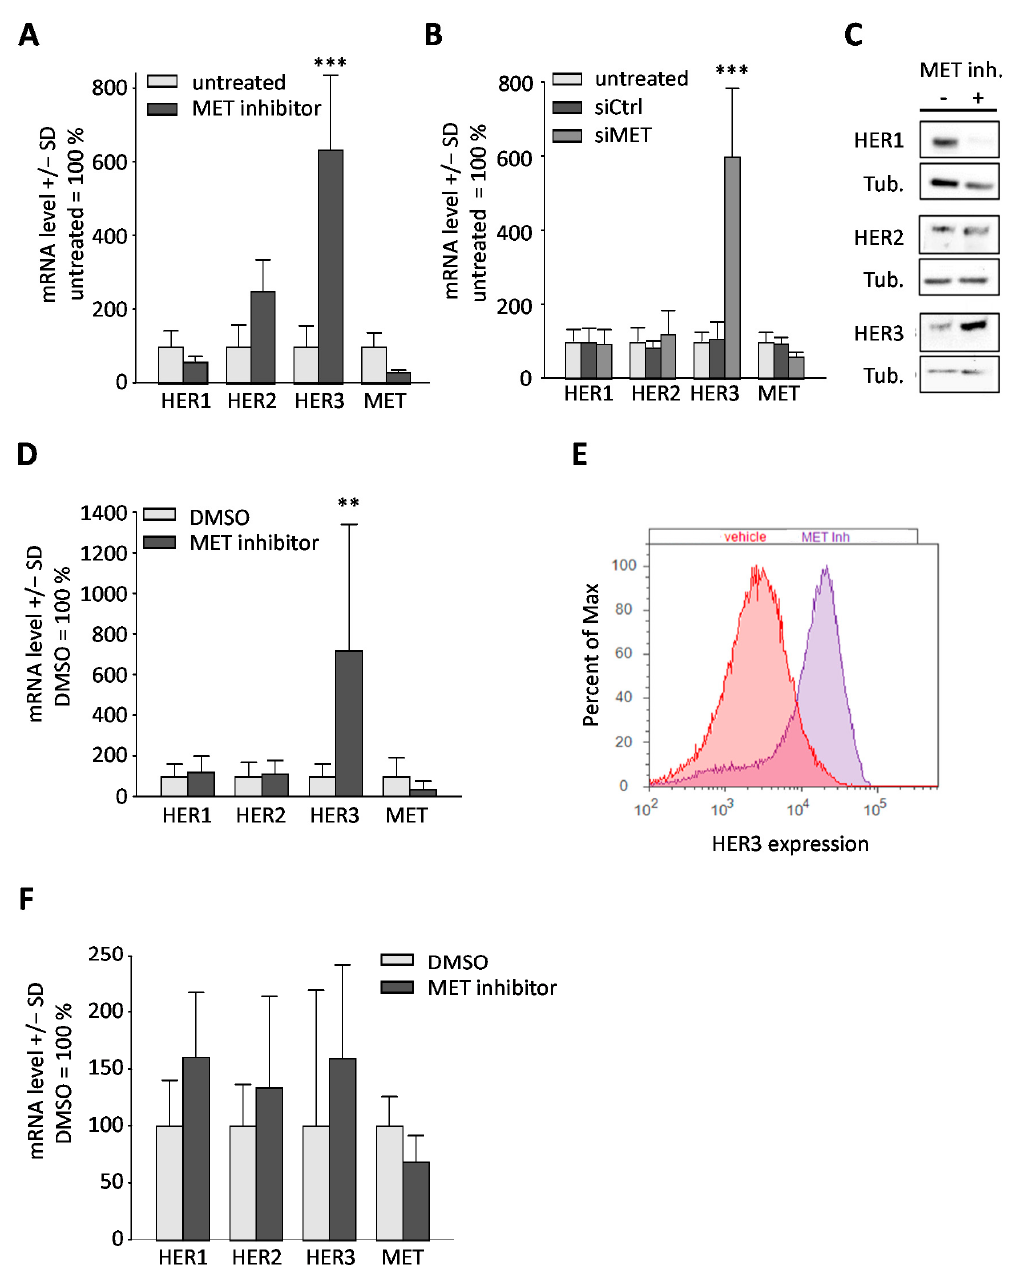
Figure 2. Inhibition of MET leads to HER3 receptor upregulation in MET-amplified MKN45 and SNU5 cells, but not in Hs746T cells. ( A ) After treatment of MKN45 cells, with MET inhibitor PF04217903 (0.2 µM for 48 h) a pronounced upregulation of HER3 was traceable on mRNA level. ( B ) Transfection of MKN45 cells with specific siRNA against MET for 48 h yielded similar HER3 upregulation results. ( C ) Accordingly, 48 h treatment of MKN45 cells with 0.2 µM of PF04217903 also led to upregulation of HER3 on protein level, whereas differential effects occurred for HER1 and HER2. ( D ) In SNU5 cells, treatment with 0.2 µM PF04217903 also showed marked HER3 upregulation on mRNA level. ( E ) Moreover, a shift in expression of HER3 protein level was observed after 0.2 µM PF04217903 treatment (48 h). ( F ) Contrastingly, no HER3 upregulation was traceable in Hs746T cells under these conditions. Level of significance: **, p < 0.01, and ***, p < 0.001.